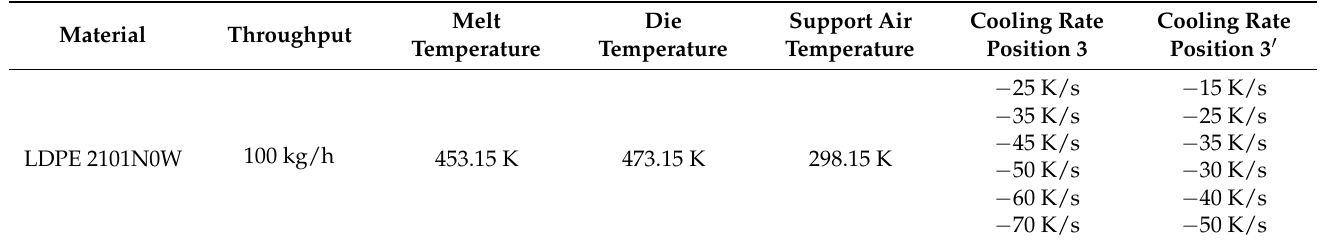
Figure 16. Heat pipe position for two heat pipes.